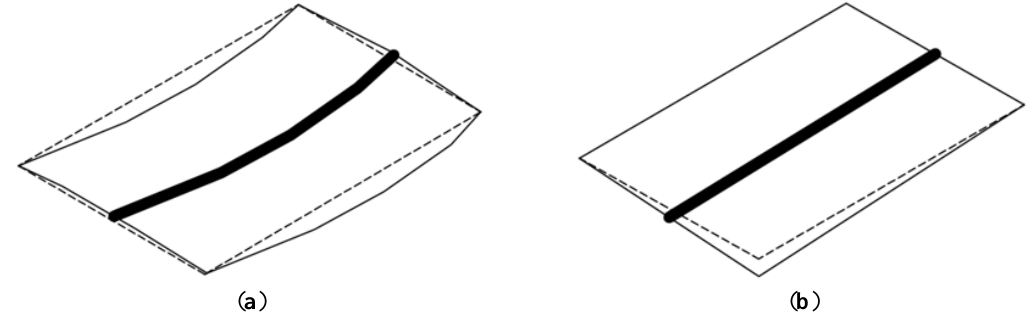
Figure 7. Deformation types in the test plates: ( a ) vertical saddle bulge; ( b ) horizontal twisting.